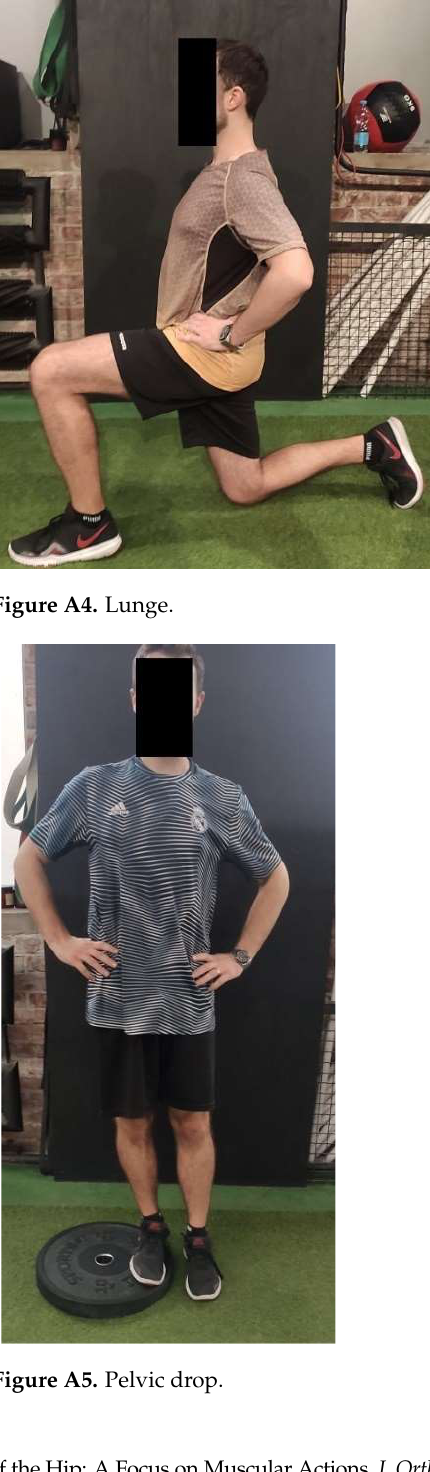
Figure A5. Pelvic drop.